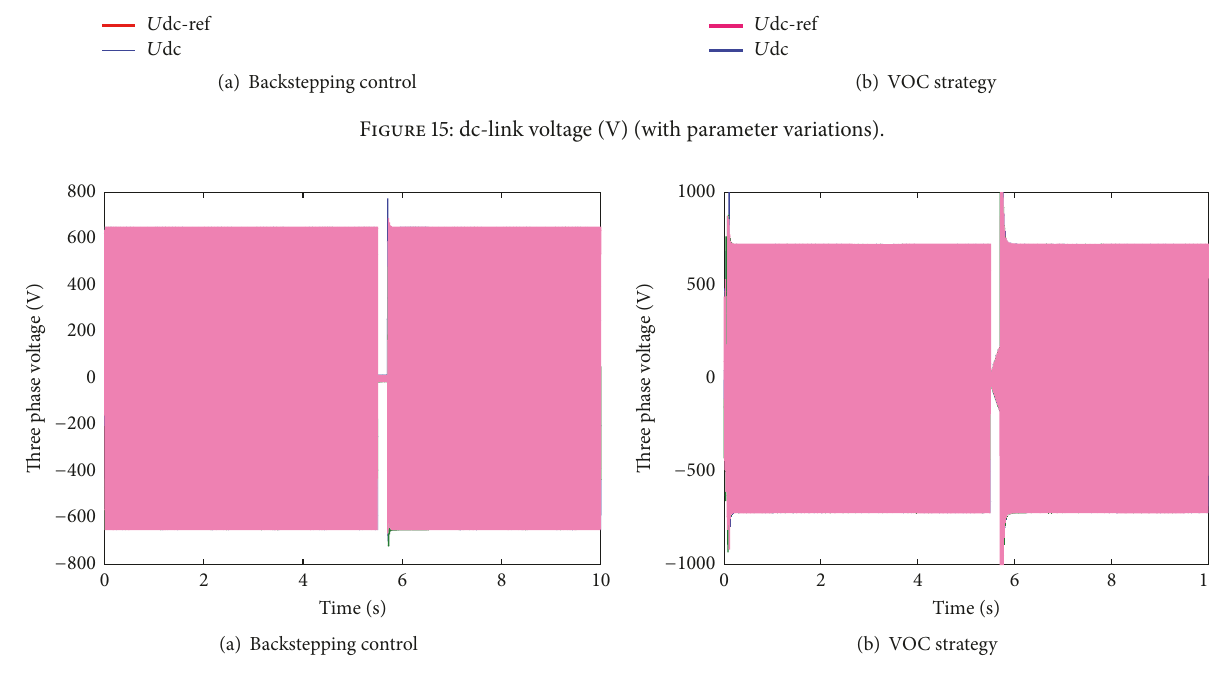
Figure 16: Waveforms of three-phase voltage at Bus 4.